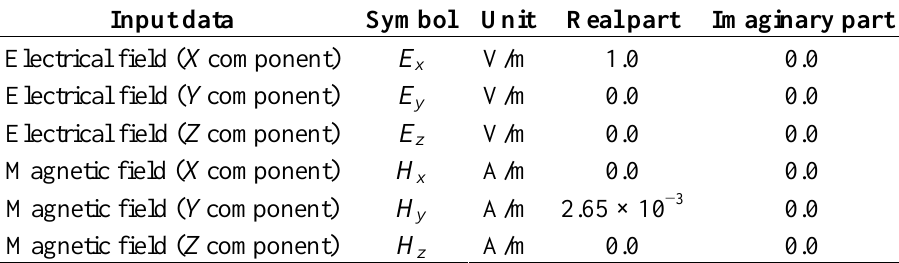
Fig. 2 Boundary conditions of micro-sized numerical Table 1. Boundary conditions of a micro-sized model.